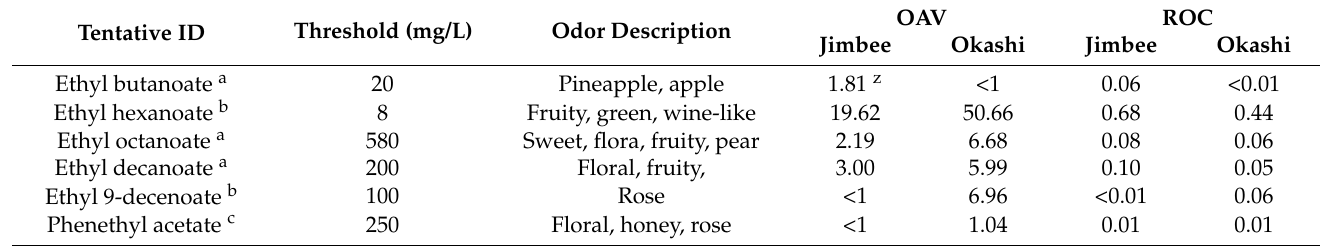
Table 6. Volatile compounds identified with OAV > 1 and its ROC for the Jimbee and Okashi melon